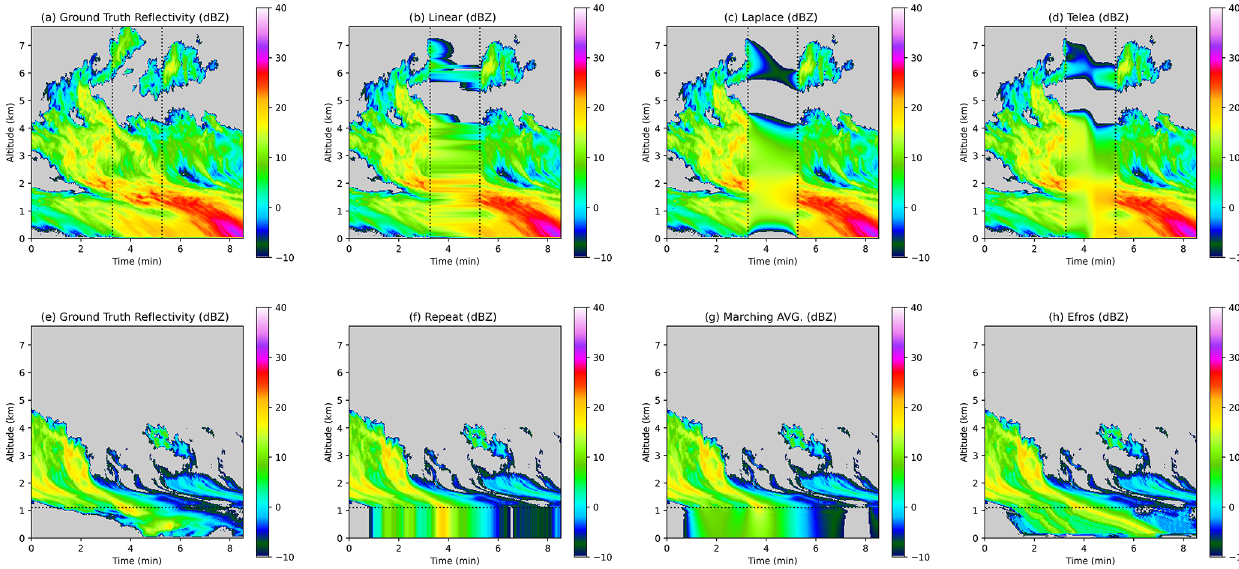
Figure 2. Example outputs demonstrating each of the benchmark inpainting schemes applied to KaZR reflectivity data. Panels (b) – (d) demonstrate the schemes used for both the KaZR outage (shown) and C-SAPR2 beam blockage scenarios red (not shown). Panels (f) – (h) show the schemes used for the low-level blind zone scenario. Ground truth is shown in panels (a) and (e) (left